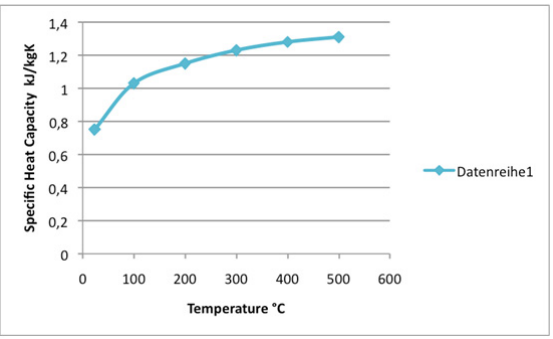
Fig. 2 specific heat capacity of Borofloat 33.